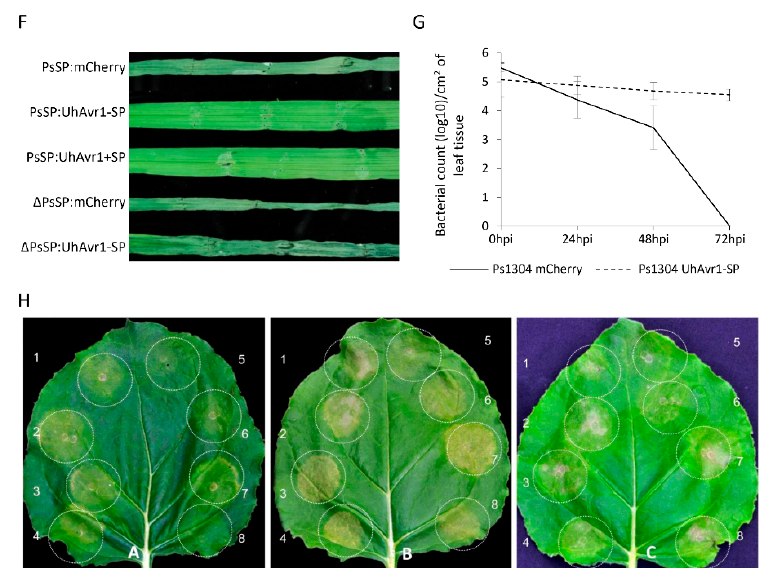
Figure 4. UhAVR1 triggers defence during the incompatible interaction and suppresses a conserved target of plant immunity during the compatible interaction. ( A ) Deduced fungal biomass during infection by WT or UhAvr1m teliospores in cv. Hannchen and ( B ) cv. Odessa. Fungal biomass was deduced by calculating the ratio between the expression levels of fungal ( UhGAPDH ) and barley ( HvUbiq ) reference transcripts. Differential fungal biomass was observed starting from 48 hpi. Graphs show the average of three independent biological repeats, with error bars depicting the corresponding standard deviations. ( C ) N. benthamiana leaves agroinfiltrated with VOX:UhAvr1+SP triggered accelerated strong necrosis at 6 dpi (arrows) which was not yet observed with constructs expressing UhAVR1 lacking a SP, GFP and the empty vector. The experiment was repeated three times with similar results and a representative image is shown. ( D ) Protein blots confirmed expression of UhAVR1 in N. benthamiana using the VOX system. Samples were collected from agroinfiltrated leaves at 4 dpi and upper non-inoculated leaves at 13 dpi from the same batch of plants shown in the image of panel C. The blots show the presence of the full-length UhAVR1-SP (19 kDa), UhAVR1+SP (21 kDa) and GFP (27 kDa) at 4 dpi. At 13 dpi, UhAVR1-SP could be detected in the upper non-inoculated leaves. Coomassie staining of the large subunit of Rubisco is shown as loading control. Protein blot analysis performed on one of the experimental repeats is shown to verify virus infection and protein accumulation. The picture shown is cropped from the same blot membrane. ( E ) Resistant barley cultivars display HR-like symptoms upon VOX-mediated delivery of UhAvr1+SP. L2 leaves expressing VOX:UhAvr1+SP (white bar) exhibit strong HR-like symptoms in cvs. Hannchen and SM89010 carrying Ruh1 at 13 dpi. Images show three representative L2 leaves from three different barley plants for each construct. All images were taken from the same experimental repeat using the same settings. ( F ) UhAVR1 suppresses Pseudomonas -induced cell death. mCherry, UhAvr1-SP and UhAvr1+SP with a bacterial T3SS SP sequence (PsSP) were delivered into the leaves of 10-day-old cv. Odessa using P. syringae pv. atropurpurea 1304 ( Psa 1304). At 48 hpi, PsSP:mCherry triggered cell death but not the constructs PsSP:UhAvr1-SP or PsSP:UhAvr1+SP. Whereas, deletion of the Pseudomonas SP ( Δ PsSP) could not prevent cell death for Δ PsSP:UhAvr1-SP. ( G ) Psa 1304 expressing UhAVR1-SP counteracts the nonhost resistance response in barley. Leaves of cv. Odessa were infiltrated with Psa 1304 expressing PsSP:mCherry or PsSP:UhAvr1-SP and bacterial counts were made up to 72 hpi. The bacterial population of Psa 1304 expressing PsSP:mCherry declined drastically (six-fold) whereas the population expressing PsSP:UhAvr1-SP declined only slightly. The graph shows the average of a minimum of three experimental repeats for each time point with their corresponding standard deviation shown as error bars. ( H ) UhAVR1 suppresses plant cell death induced by three elicitors in N. benthamiana . N. benthamiana leaves were agroinfiltrated with: (1) empty pMCG161:GW:GFP, (2) empty pMCG161:GFP:GW, (3) pEAQ:GFP, (4) pBIN61:GFP, (5) pMCG161:UhAvr1-SP:GFP, (6) pMCG161:GFP:UhAvr1-SP, (7) pEAQ:GFP or (8) pBIN61:GFP. Twenty-four hours later, the same regions were agroinfiltrated with three different cell death inducers: (A) AvrBs2/Bs2 , (B) auto-active